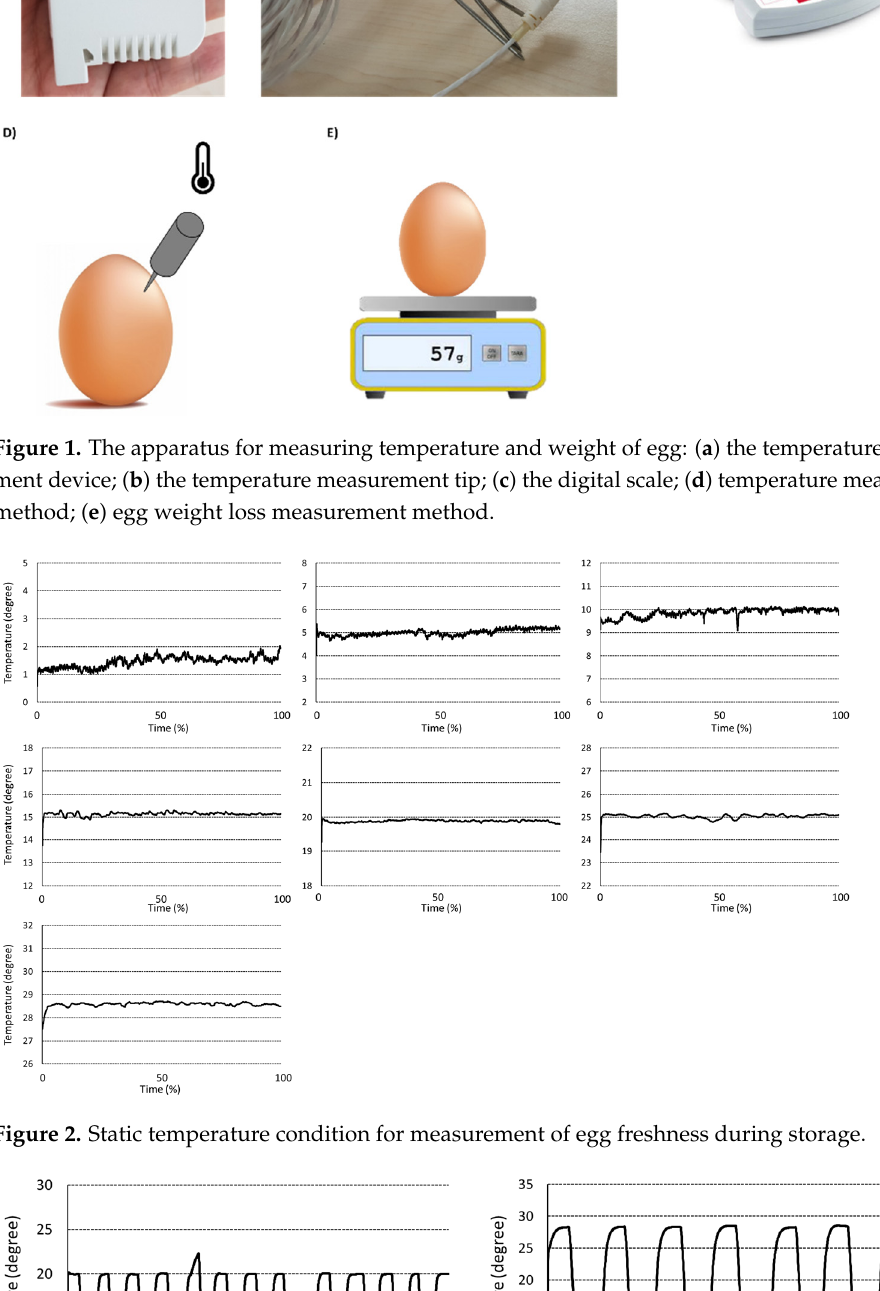
Figure 4. Real-time cold chain temperature condition for measurement of egg freshness.